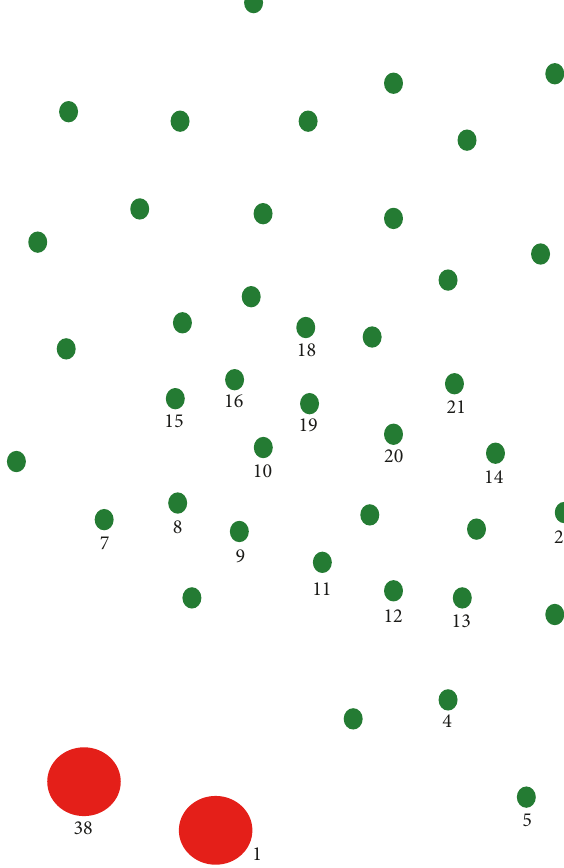
Figure 3: Nodes 1 and 38 process